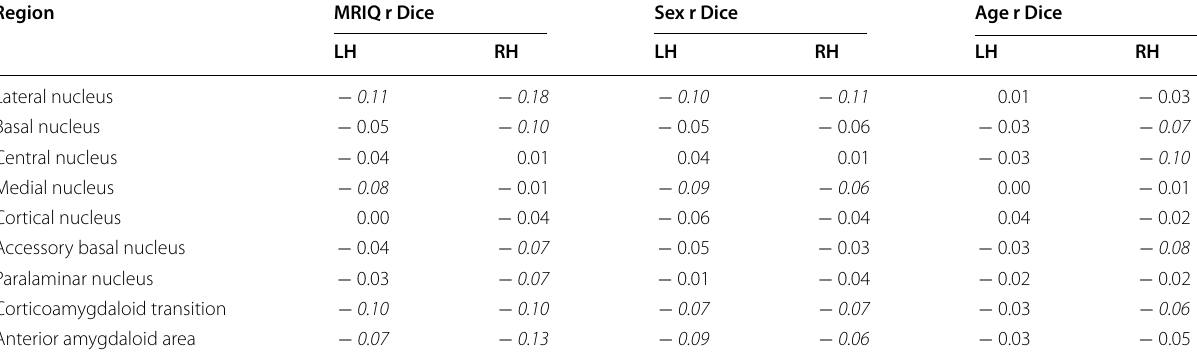
These were completed for left hemisphere LH and right hemisphere (RH) Correlations with p < 0.05 are highlighted in Italic